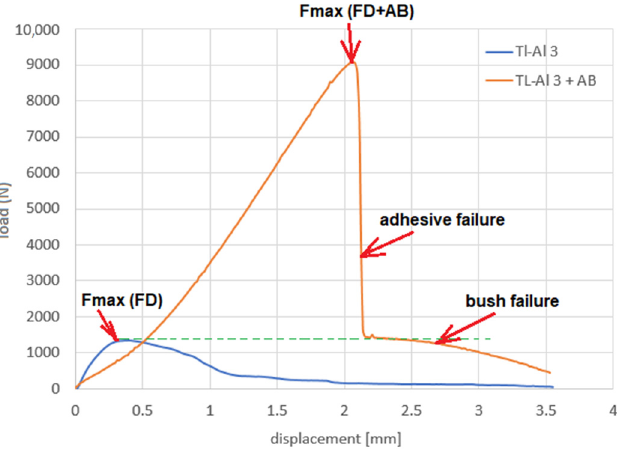
Figure 15. Typical regions on load-displacement curves. A comparison of typical load-displacement curves of all flowdrill joints and joints combined with adhesive bonding are shown in Figure 16.